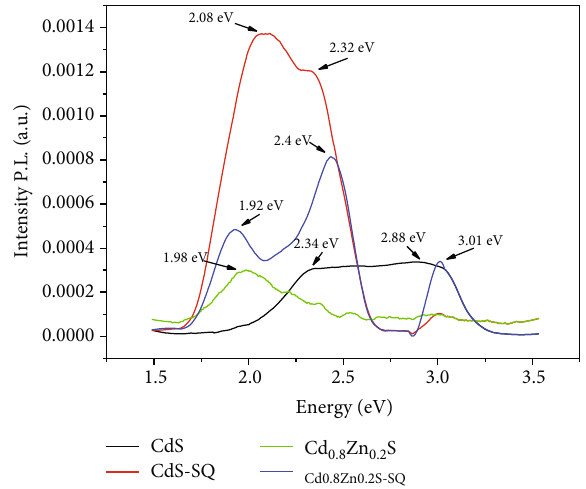
Figure 9: PL spectra of CdS, CdS-SQ, Zn SQ obtained by coprecipitation and sonochemistry methods.